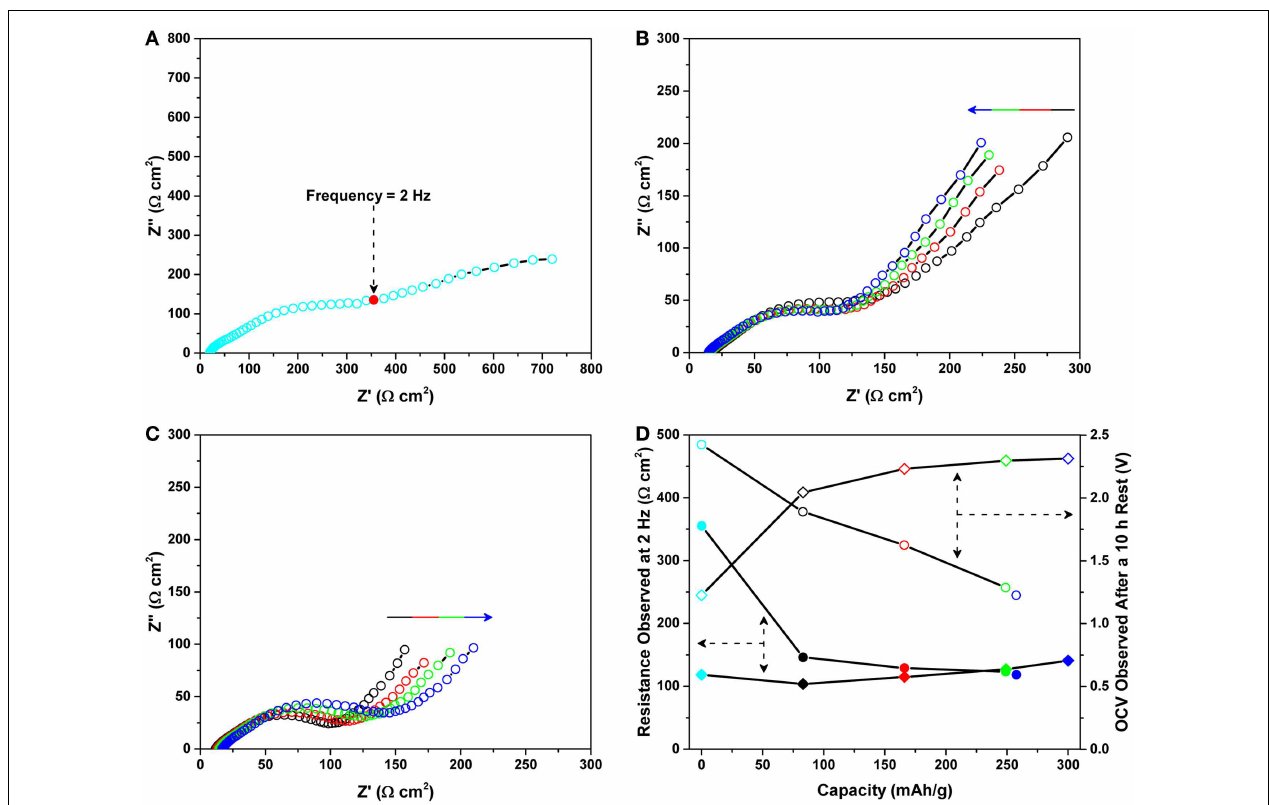
of magnesiation/de-magnesiation. (D) shows the impedance data observed for the initial cycle. Shaded circles and diamonds denote data recorded at 2Hz during magnesiation and de-magnesiation, respectively. Unshaded circles and diamonds represent the values of OCV recorded during impedance